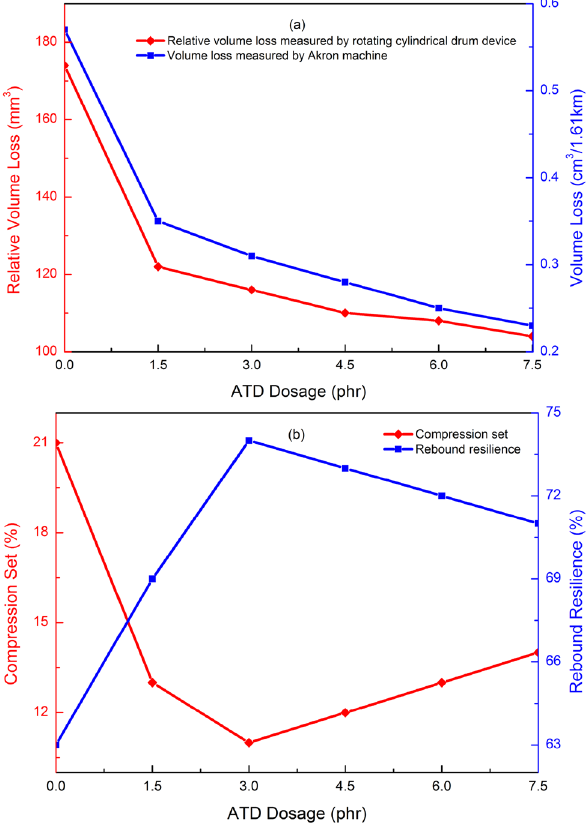
Figure 5: Variation of ( a ) storage modulus ( log ( E ′ /Pa )) , ( b ) loss modulus ( log ( E ″ /Pa )) , and ( c ) dynamic loss coe ffi cient ( tan δ ) with temperature for modi fi ed IR/silica/CB vulcanizates with